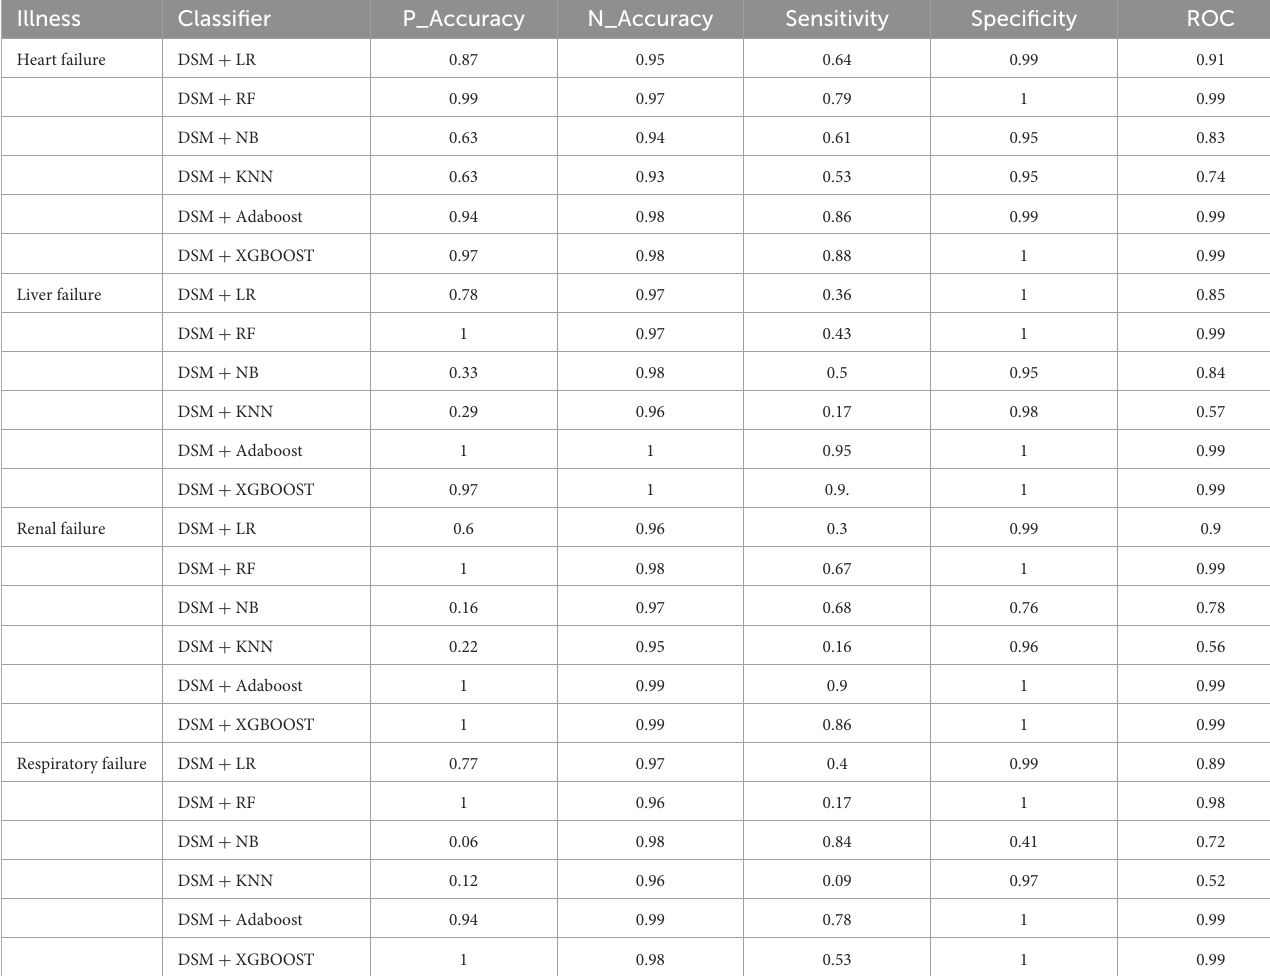
TABLE 4 Temporal data experiments